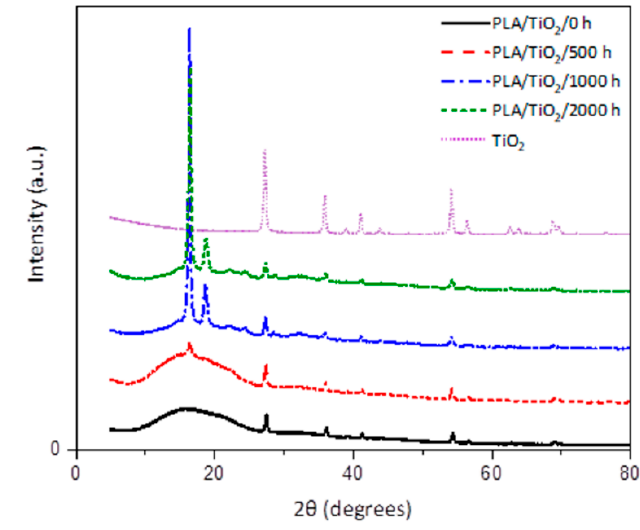
Figure 6. X-ray di ff raction spectra of PLA / TiO 2 nanocomposite at di ff erent accelerated weathering